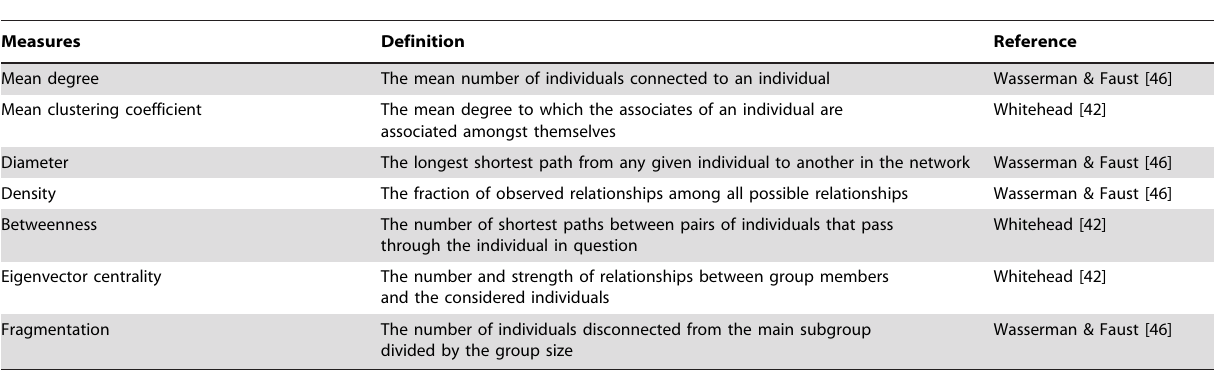
Table 2. Network analysis measure